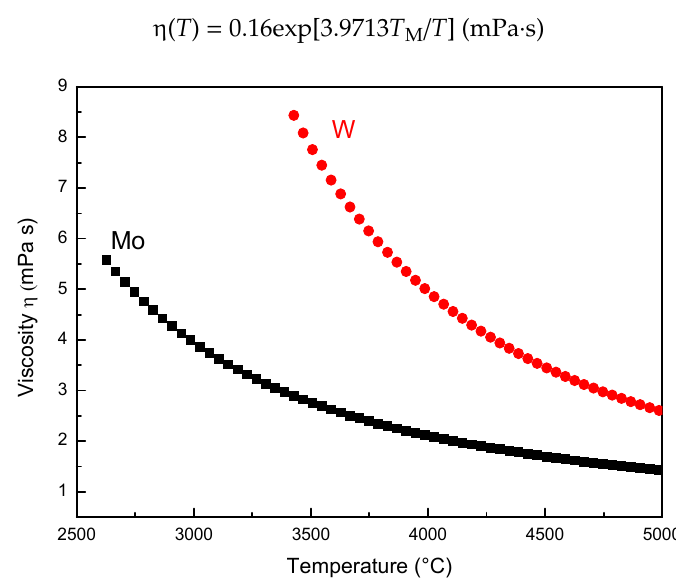
Figure 8. Viscosity of W and Mo vs. temperature, calculated according to Equations (5) and (6).